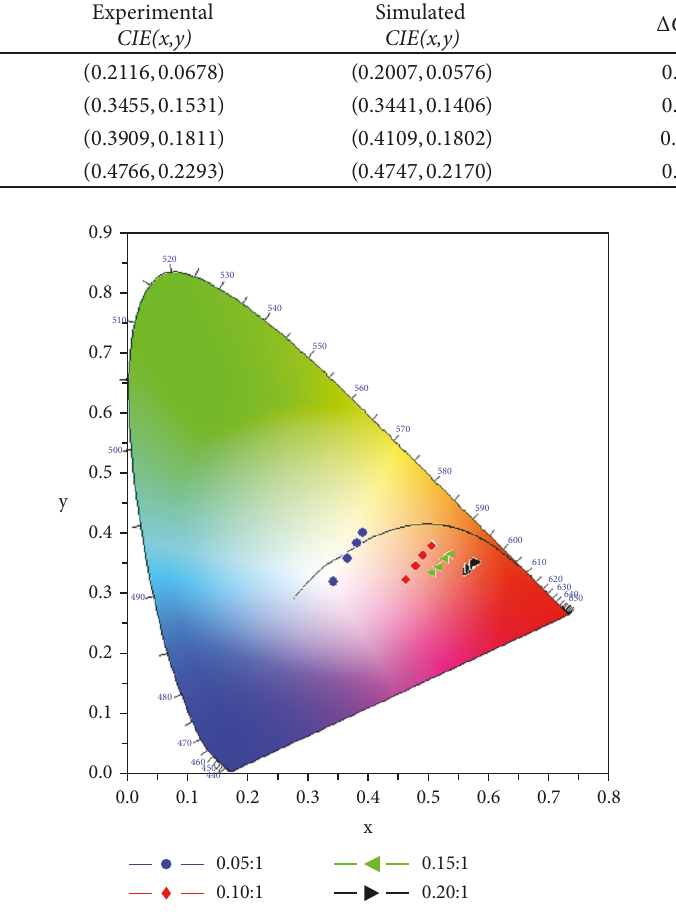
Figure 12: Color coordinates distribution of green and red laminated remote phosphor film